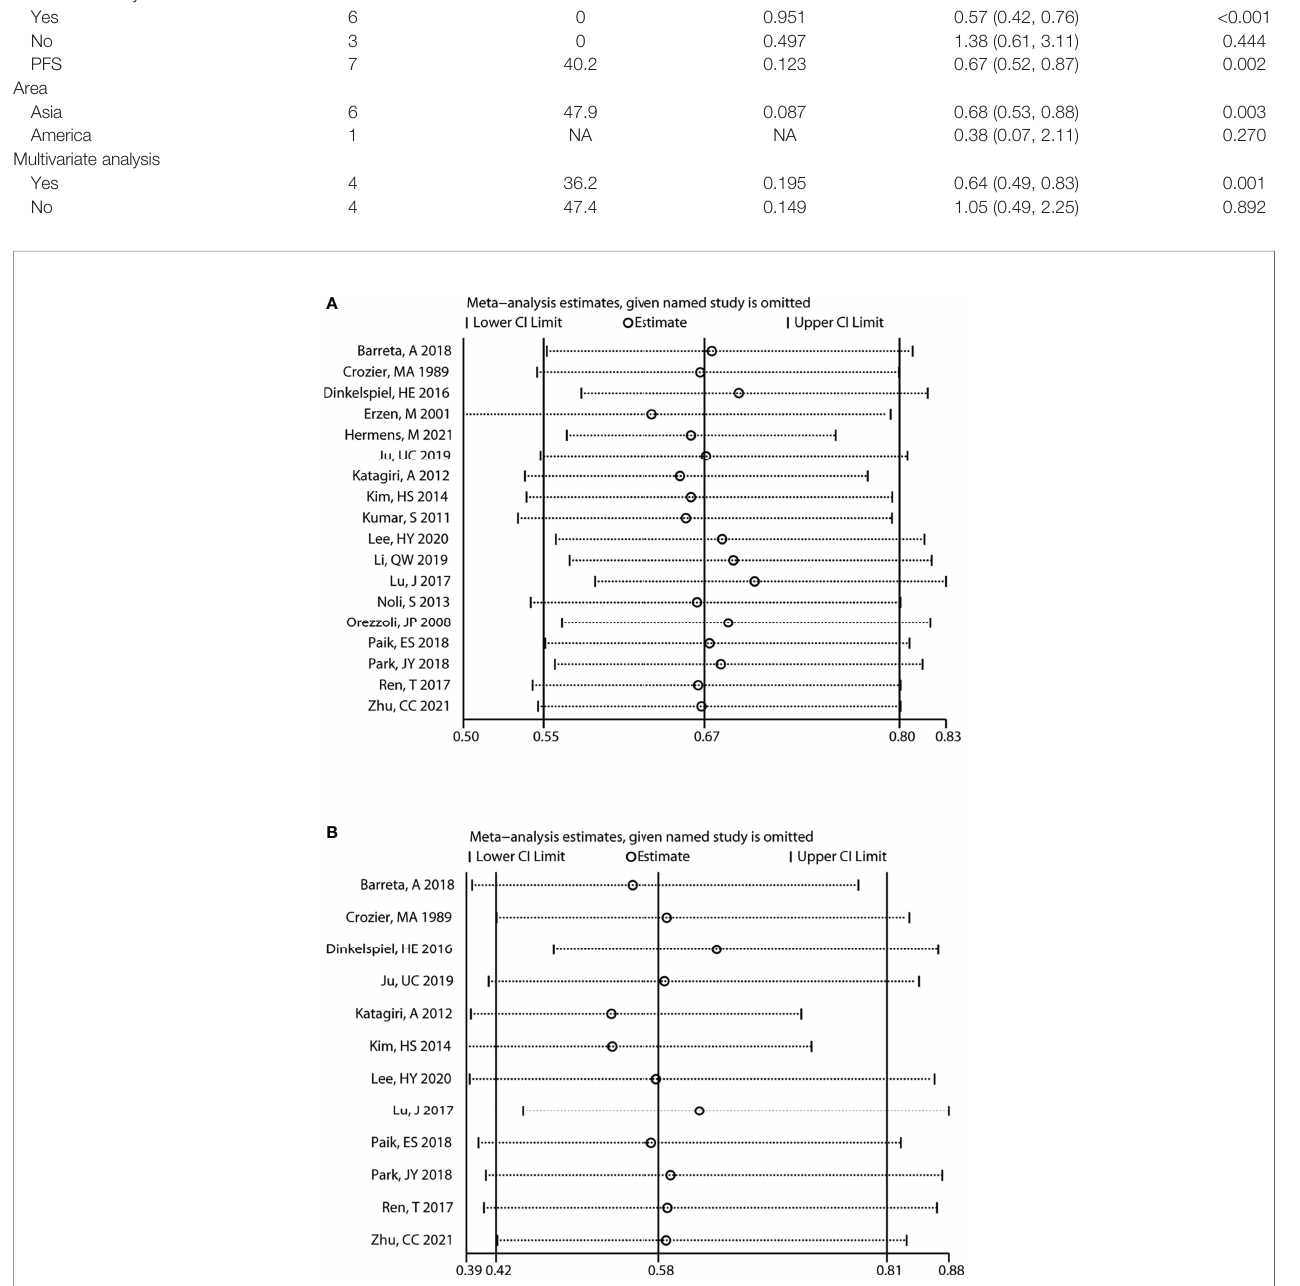
FIGURE 4 | Sensitivity analysis for the results of total OC. Sensitivity analysis to evaluate the stability of the pooled results for the impact of endometriosis on overall survival (A) and progression-free survival (B) of total OC patients. OC, ovarian